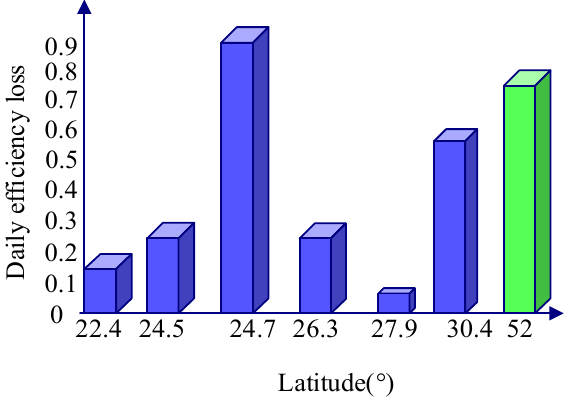
Figure 11. Maximum daily efficiency loss for various latitudes [52].